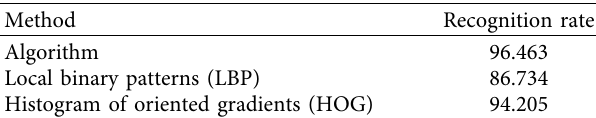
Figure 8: Partial gesture data sets. Table 2: Comparison of recognition rate. Table 3: Recognition results.